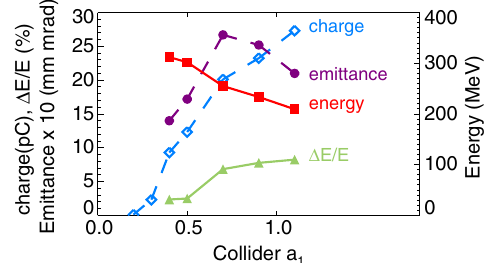
FIG. 8. Trapped charge (blue diamond), energy (red square), energy spread (green triangle), and transverse normalized emit- tance (purple circle) multiplied by 10 as a function of the collider laser intensity, for driver parameters a 0 ¼ 2 , w 0 ¼ 7 . 26 μ m and